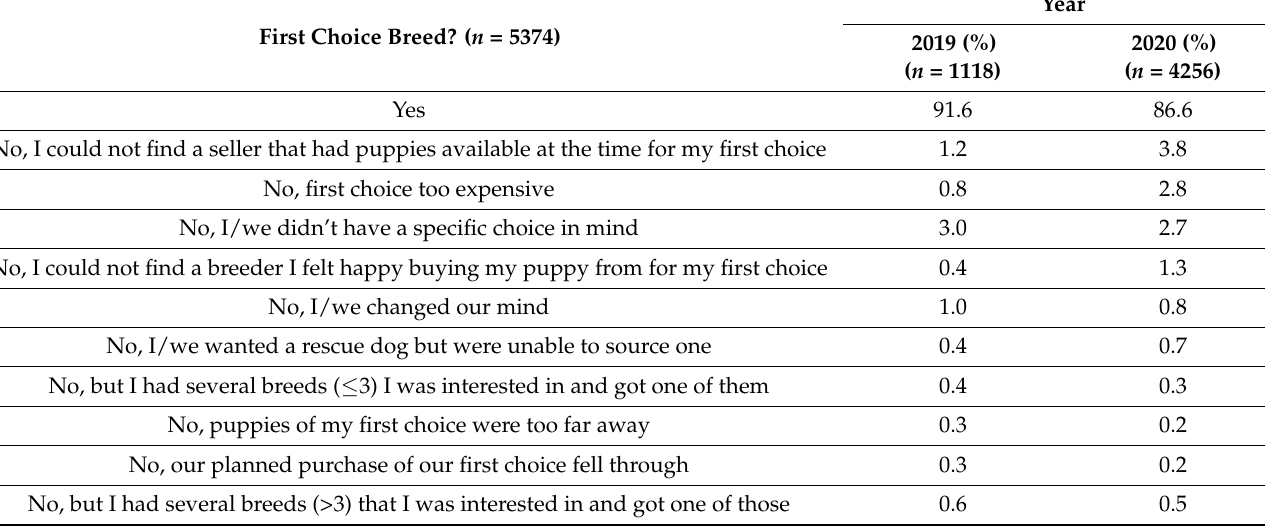
Table 9. Acquisition levels of first-choice breeds by owners and reasons for not purchasing their first-choice breed with comparison between 2019 puppy owners ( n = 1118) and Pandemic Puppy owners ( n = 4256) in the